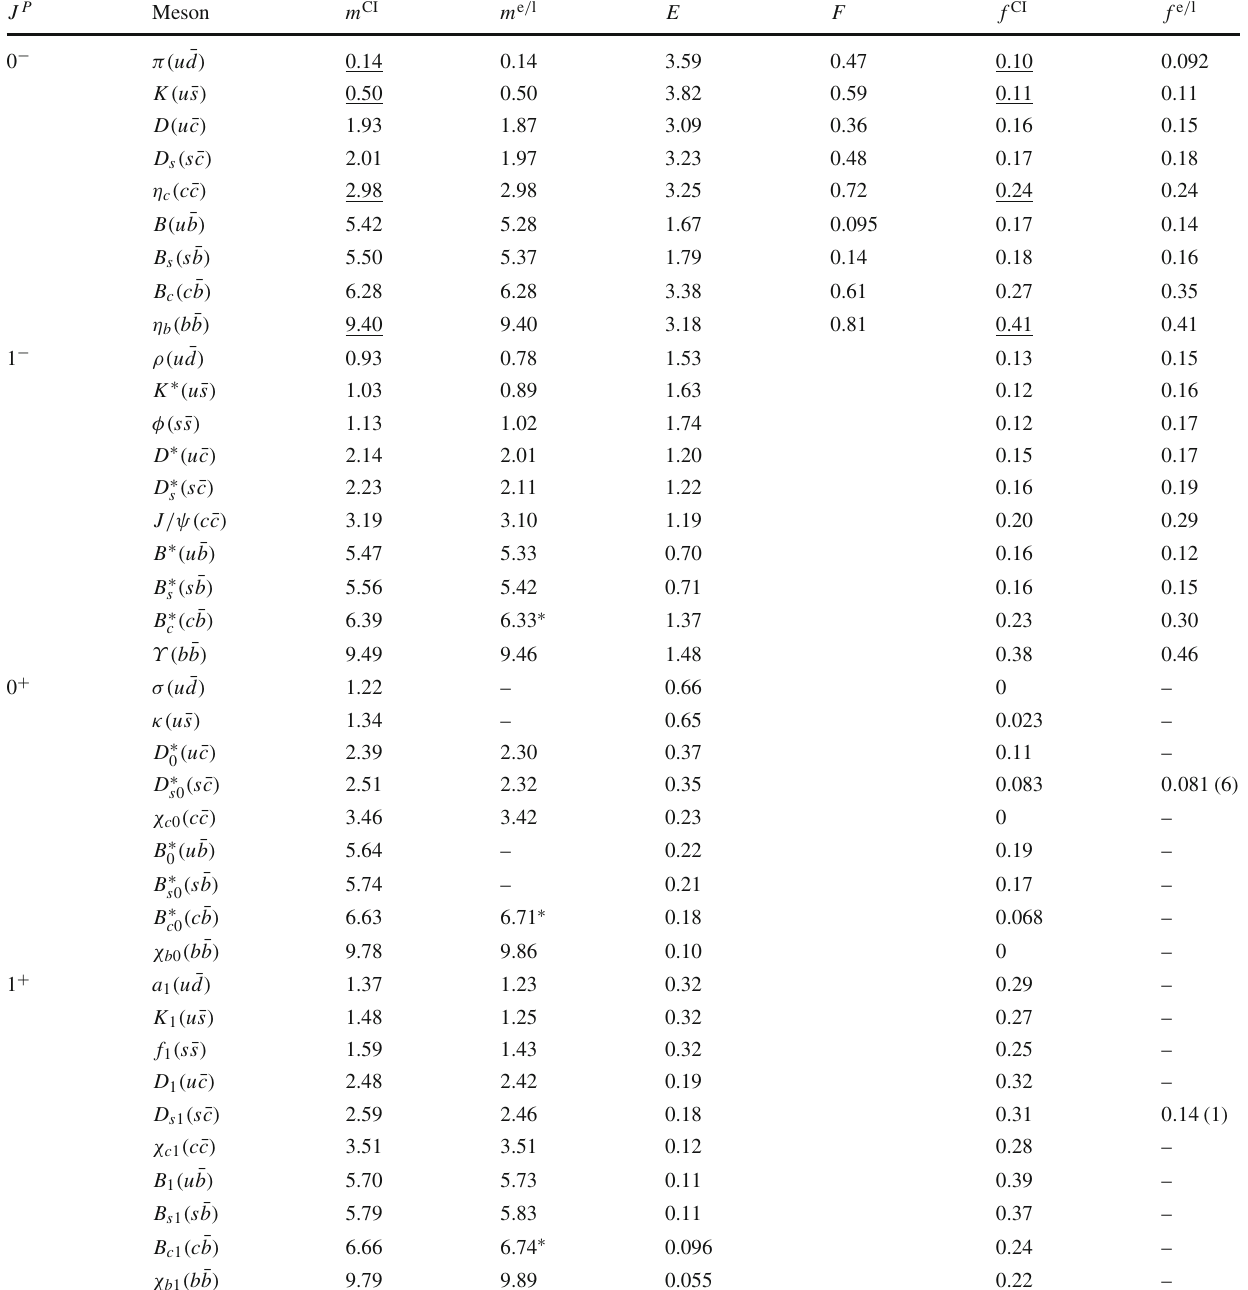
lQCD [20,64–69]. (Dimensioned quantities in GeV. Underlined entries from Table 7. “–” indicates no empirical/lQCD results available for